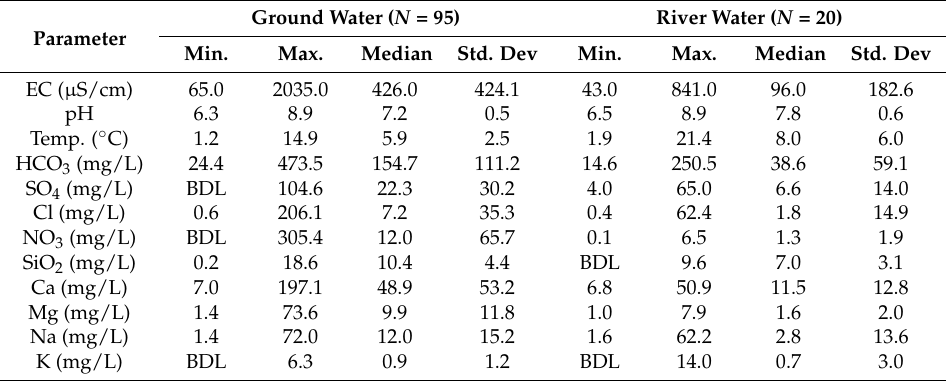
BDL: below the detection limit.